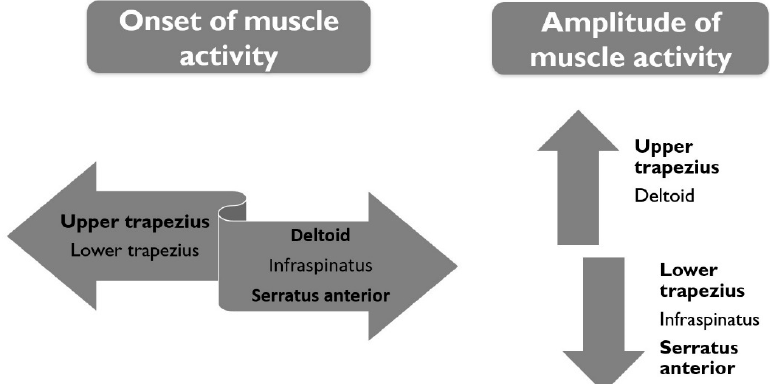
Figure 3. Summary data of shoulder muscle activity in women after breast cancer treatment.